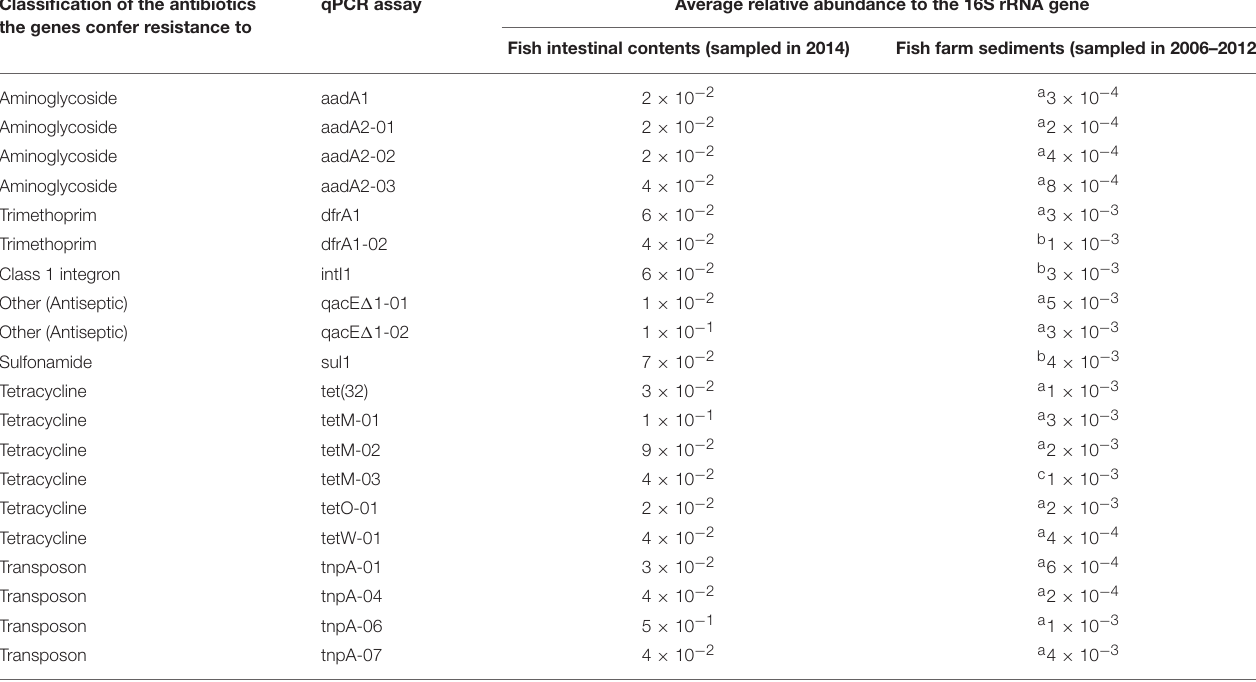
TABLE 2 | Twenty of the 28 genes detected in the farmed fish intestinal contents. Classification of the antibiotics the genes confer resistance to